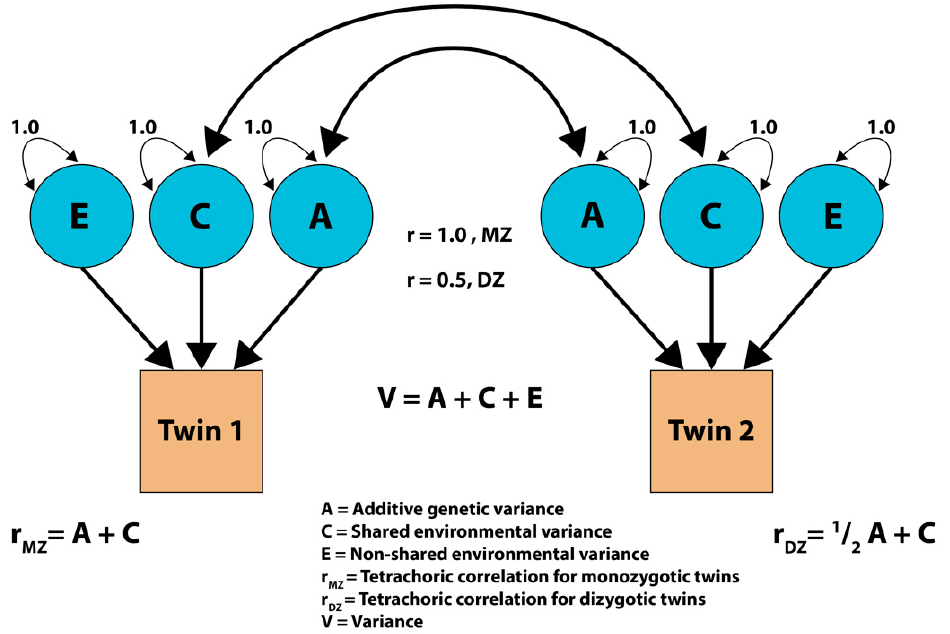
Figure 6. Graphical explanation of the ACE statistical model.